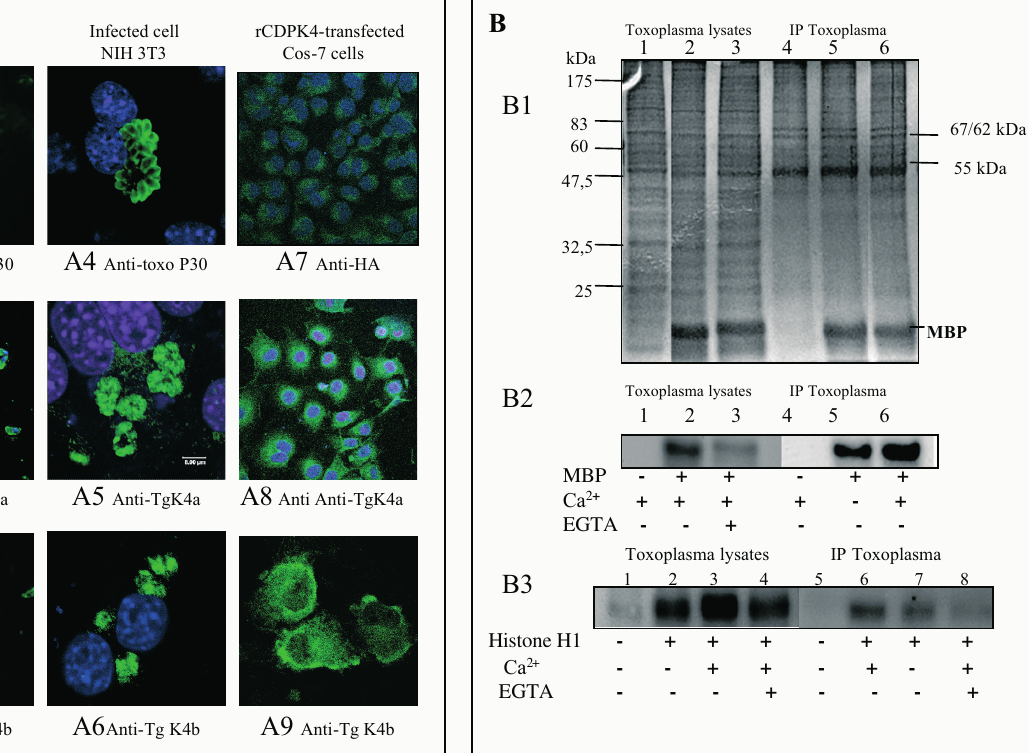
Fig. 3. – A. Immunolocalization of TgCDPK4 in Toxoplasma gondii and in transfected Cos-7 cells. Extracellular tachyzoïtes were harvested from the peritoneal fluid of mice infected four days previously with Toxo- plasma gondii and intracellular tachyzoïtes were obtained from infected NIH 3T3 cells, as described (Roisin et al., 2000; Creuzet et al., 1998). Parasites were detected with a mouse monoclonal anti- Toxoplasma anti- body (panel A1 and A4) or with specific antiTg-K4 antibodies, stained by incubation with CY3-conjugated anti mouse IgG or CY3-conjugated anti rabbit IgG, and FITC- conjugated anti rabbit IgG, respectively (panels A2, A3, and A5, A6). Cos-7 cells were transfected with the expression vector pAS1B-Tg CDPK4 encoding HA epitope- tagged TgCDPK4. Cells were fixed and per- meabilized 24 h after transfection. TgCDPK4 was detected with an anti-HA antibody panel A7 or with specific the anti-TgCDPK4 antibodies anti-Tg K4a (A8) or anti-TgK4b